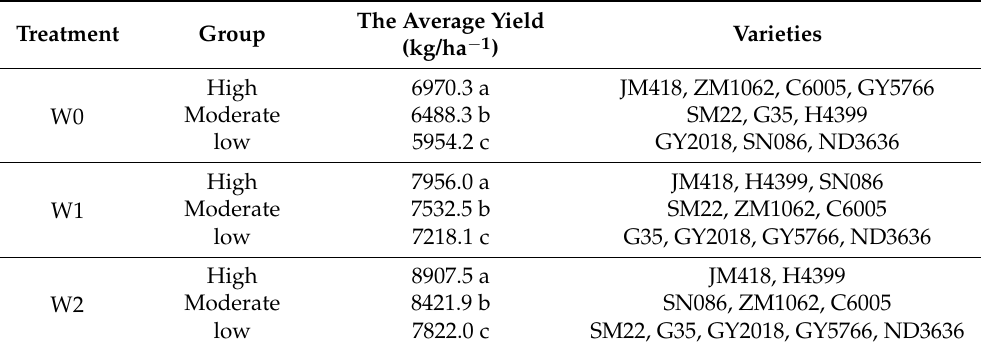
Table 4. Yield-based hierarchical clustering in different deficit irrigation treatments and the average value of each group was also